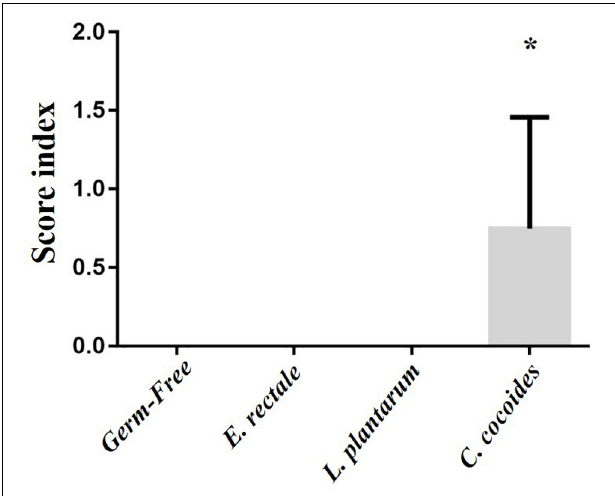
FIGURE 10 | Effect of indicated gnotobiotic groups on pathological evaluation. Data are mean ± SEM ( n = 6–8/group) and ∗ P < 0.05, mean the significant different as compared with GF, E. rectale , and L. plantarum